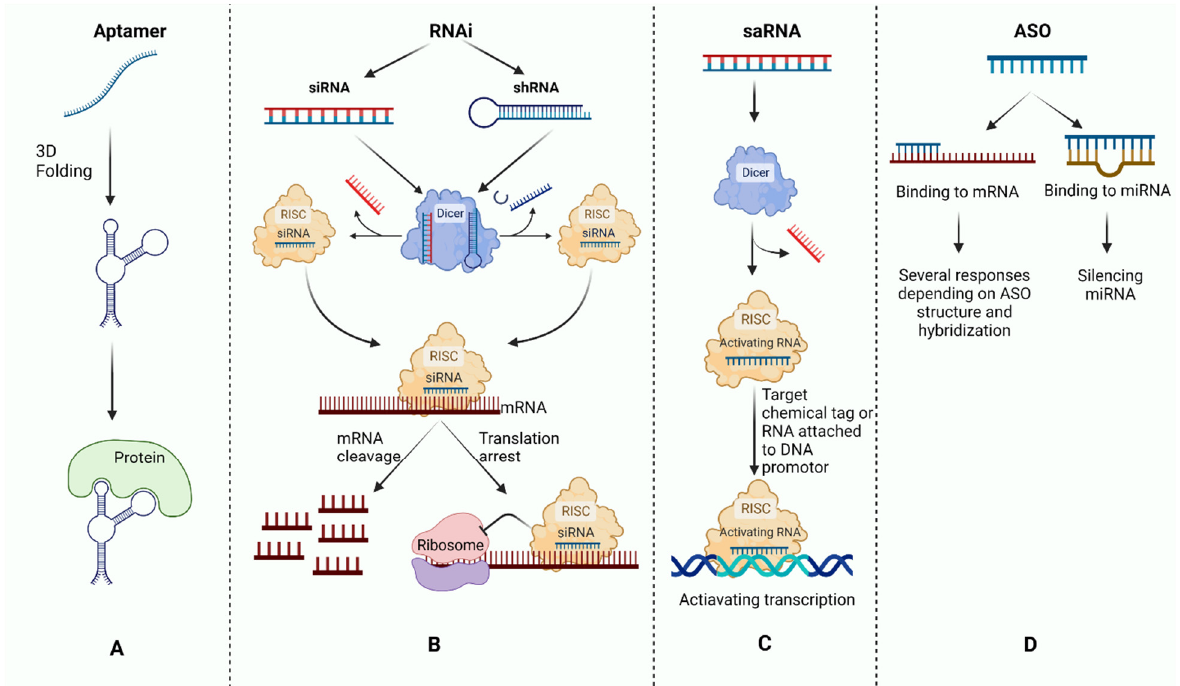
Figure 1. ( A ) Aptamers consist of 3D-folded single-stranded oligonucleotides with the ability to bind to proteins and peptides. They can inhibit the function of target proteins and peptides. ( B ) RNA interference (RNAi) oligonucleotides are double-stranded RNAs and include small interfering RNAs (siRNAs) and small hairpin RNAs (shRNAs). Dicer enzyme cleaves double-stranded RNAi, and antisense (guide) strands degrade target mRNAs or arrest translational processes via an RNA- induced silencing complex (RISC). RISC is a multiprotein complex that alternates gene expression. The miRNAs or siRNAs are loaded on an RISC and attach to their complementary mRNA tran- scripts. An RISC-associated protein or Argonaute is then activated and inhibits protein synthesis by cleaving mRNA or arresting translational process. The siRNAs transport to cell cytoplasm and are associated with Dicer/RISC, but shRNAs initially transport to cell nuclei using a vector for transcrip- tion. The product will then export to cell cytoplasm and will be associated with Dicer/RISC. ( C ) Small activating RNAs (saRNAs) are double-stranded RNAs activating gene expression via an RISC. The saRNAs are loaded on RISC and bind to chemical tags or RNA copies attached to DNA that prevent promoter activation. Argonaute is then activated and increases gene expression by re- moving these chemical tags and RNA copies. ( D ) Antisense oligonucleotides (ASOs) modify gene expression by binding to mRNA or noncoding RNA (miRNA). “Schematic diagram created with premade icons and templates from biorender.com (accessed on 20 August, 2022).”